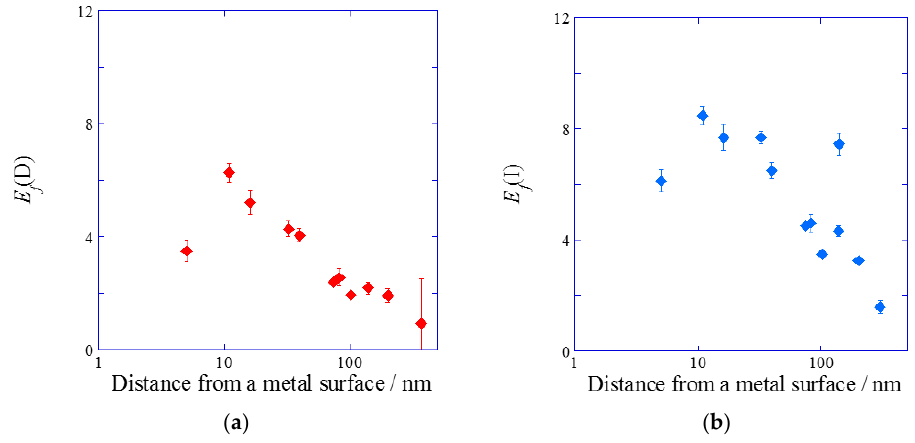
Figure 5. Enhancement factor obtained from the peak values divided by the base values ( a ) in DAS system and ( b ) in IAS system.